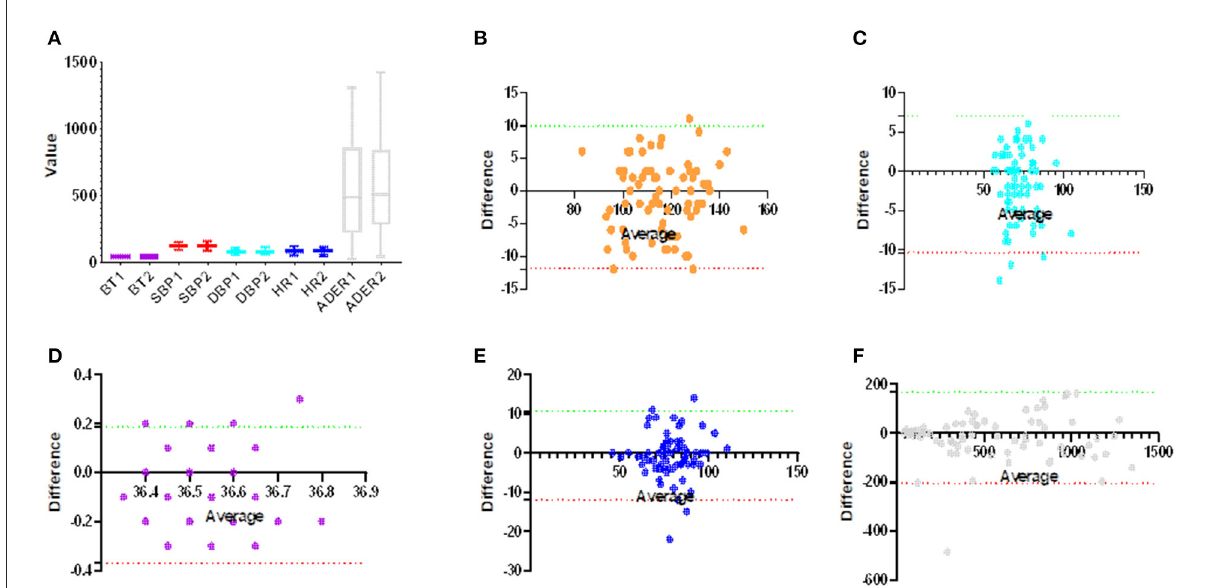
FIGURE3 Consistency of robot measurement group and control group. (A) The group diagrams show the distribution of measurements for both methods, with no significant differences between the groups ( p > 0.05). (B–F) A Bland–Altman plot of vital signs, (B) systolic blood pressure (Bias: − 1.028, 95% CI : − 11.950 and 9.897), (C) diastolic blood pressure (Bias: − 1.708, 95% CI : − 10.390 and 6.973), (D) body temperature (Bias: − 0.092, 95% CI : − 0.370 and 0.187), (E) heart rate (Bias: − 0.667, 95% CI : − 11.950 and 10.610), and (F) ambient dose equivalent rate (Bias: − 19.390, 95% CI : − 11.950 and 10.610).